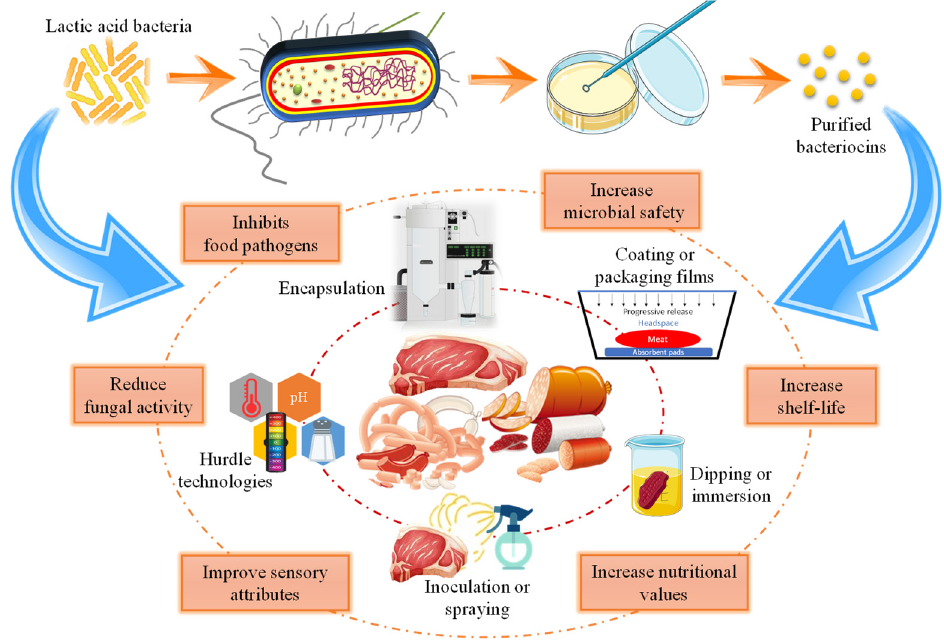
Figure 2. Biopreservative effect of lactic acid bacteria and bacteriocins on quality and safety of meat and meat products.